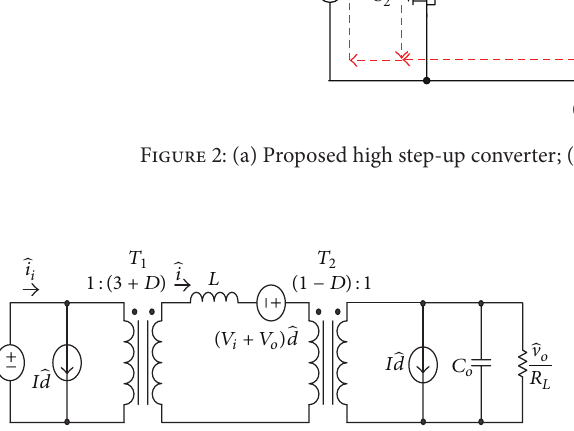
Figure 3: Small-signal AC model for the proposed high step-up